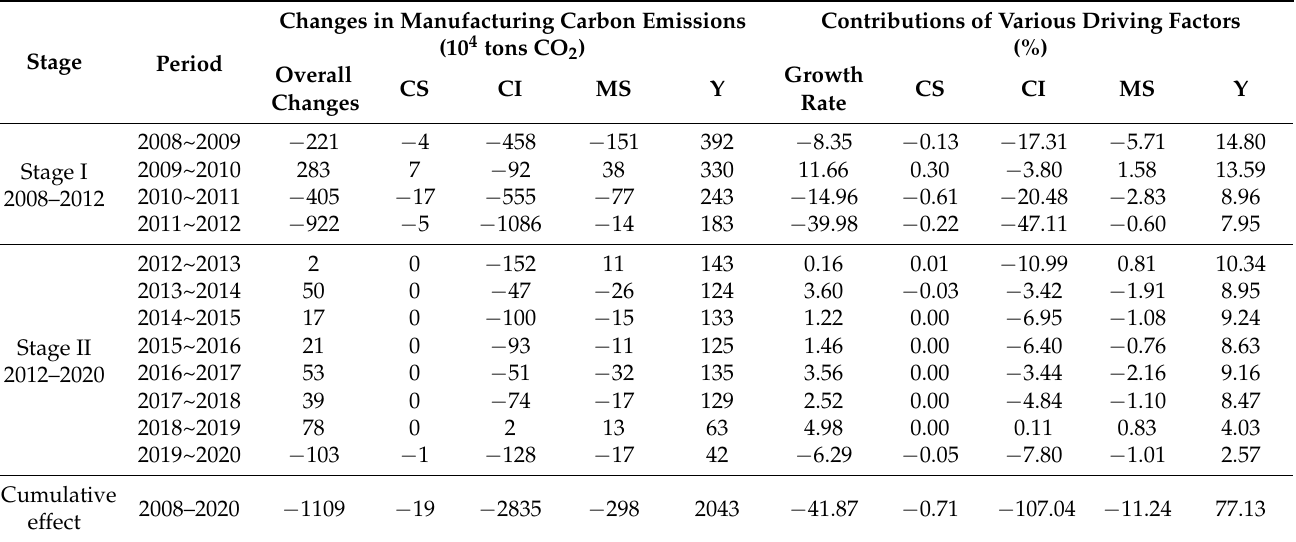
Table 6. Decomposition results of carbon emission changes and contributions of various driving